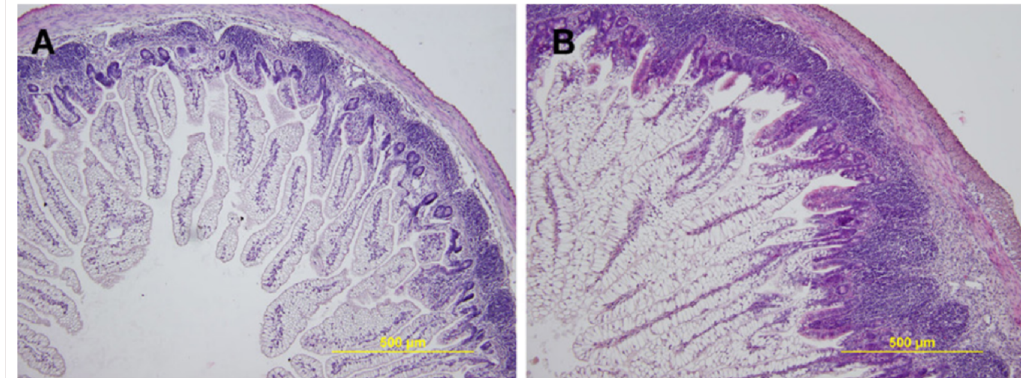
Figure 1. Cross Section Stain of Villi in the Ileum of Preterm ( A ) vs. Term ( B ) Piglets. Figure reproduced from Frontiers